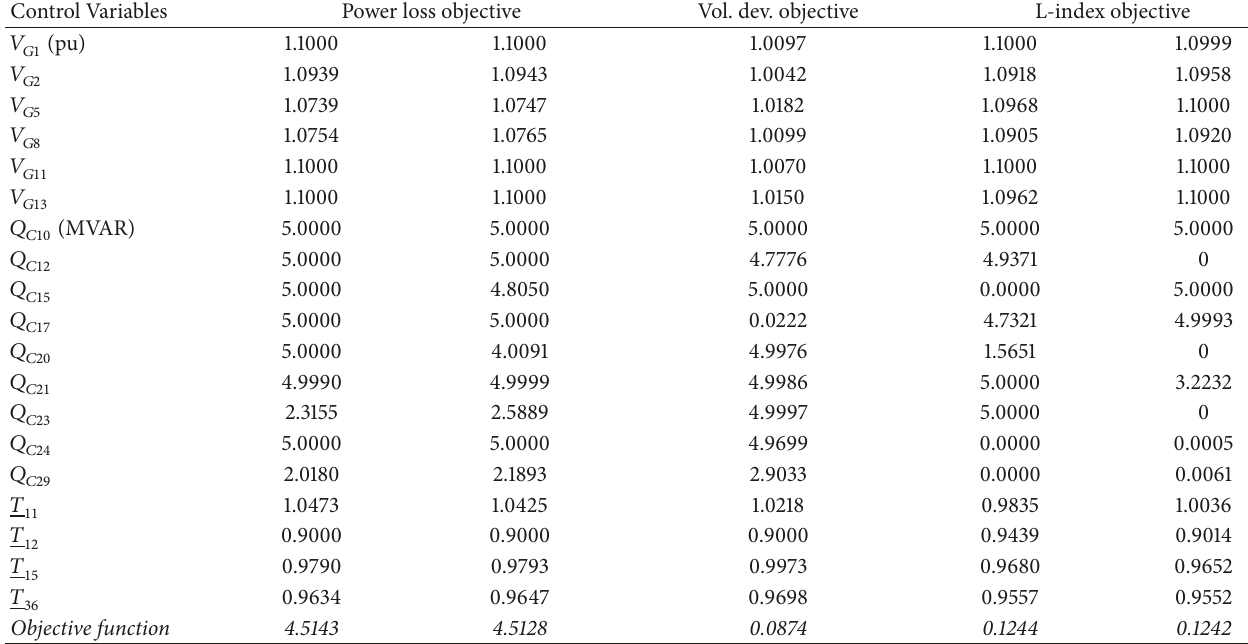
Table 14: Optimal solutions obtained by the proposed method for IEEE 30-bus system.